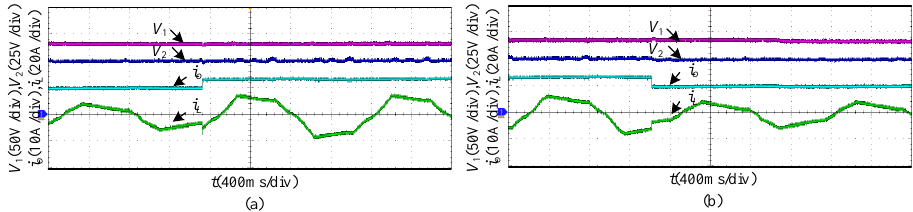
Figure 11. Transient operating waveform of the MUOC strategy when the load steps change: ( a ) the load steps from 5 to 3.79 Ω , ( b ) the load steps from 3.79 to 5 Ω